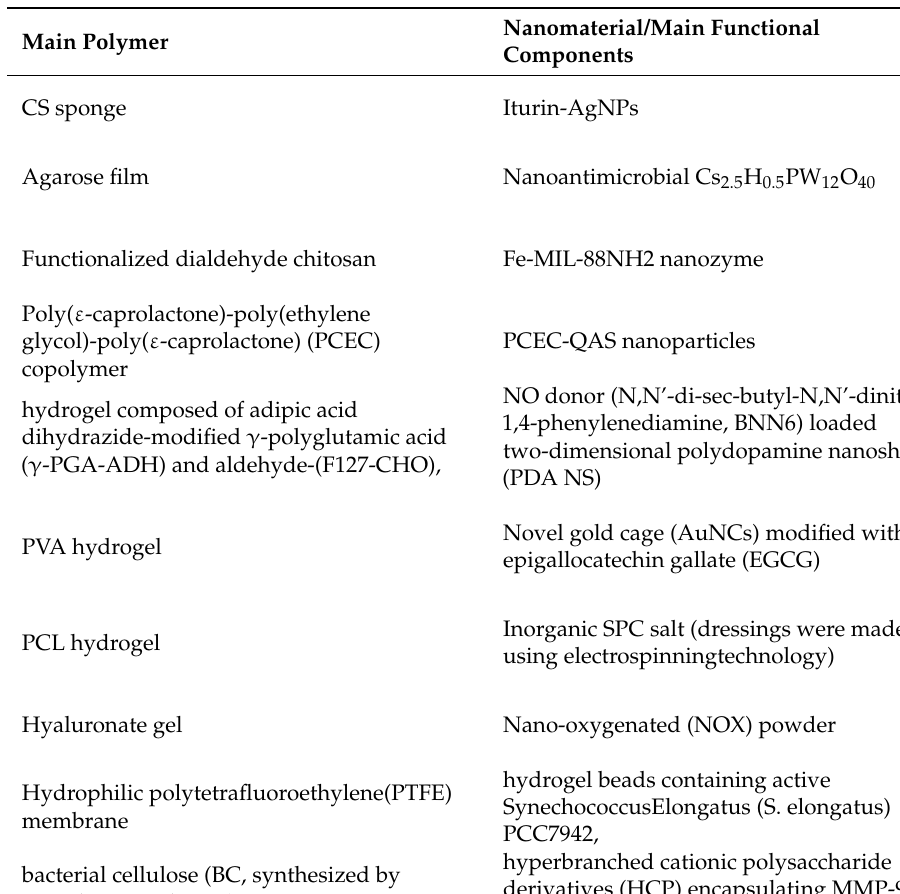
Table 1. Wound dressings composed of nanomaterial loaded with